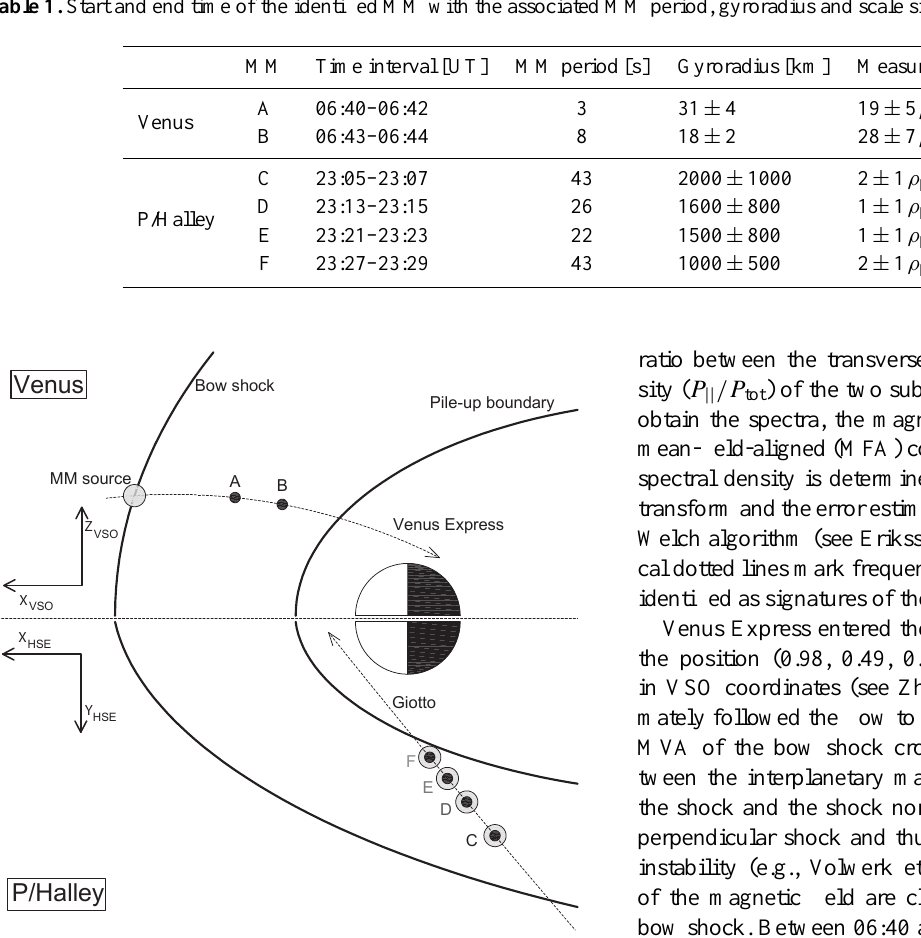
Table 1. Start and end time of the identified MM with the associated MM period, gyroradius and scale size at Venus and P/Halley.